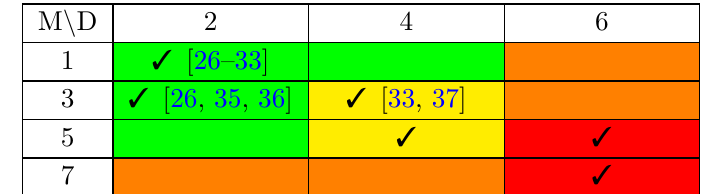
Table 1. The HMDM Model Space. Check marks correspond to pairs of Dirac (D) and Majorana (M) DM representations that can have a Yukawa coupling to the SM Higgs. The green cells are models with a Landau pole (LP) for (cid:11) 2 at (cid:3) LP M Pl , while the yellow, orange and red cells (cid:21) correspond to (cid:3) LP in [ M Pl ; 10 10 GeV], [10 10 GeV ; 10 5 GeV] and < 10 5 GeV